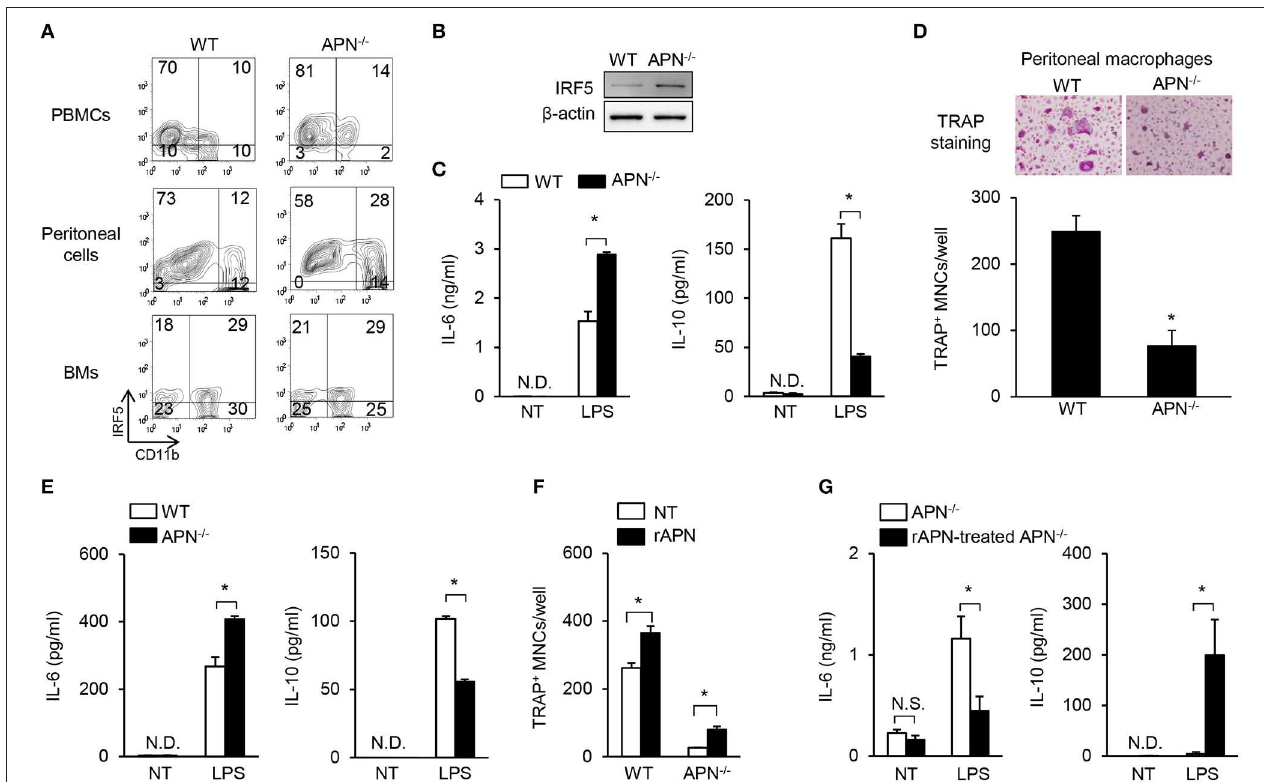
FIGURE 5 | Macrophages derived from adiponectin-deficient mice have M1-like properties and attenuated osteoclastogenic potential. (A) PBMCs, peritoneal cells, and bone marrow cells (BMs) were blocked with anti-CD16/CD32 antibody and then stained with FITC-conjugated anti-CD11b antibody. The stained cells were fixed, permeabilized, and stained with mouse anti-IRF5 antibody followed by incubation with Cy3-conjugated anti-mouse IgG. The stained cells were analyzed using flow cytometry. Numbers indicate the percentage of each panel. One of two similar results is shown. (B) BMMs were differentiated from stroma free-bone marrow cells by incubation with M-CSF (20ng/ml) for 5 days. Cell lysates were prepared and subjected to immunoblots to detect IRF5. (C) BMMs were stimulated with LPS (0.1 µ g/ml) for 24h. The culture supernatants were analyzed to determine the production of IL-6 and IL-10 using ELISA. (D) Peritoneal macrophages were isolated and incubated with M-CSF (20ng/ml) plus RANKL (40ng/ml) for 4 days. The cells were fixed and stained for TRAP. TRAP + MNCs were photographed (magnification, × 200) and enumerated. (E) Peritoneal macrophages were stimulated with LPS (0.1 µ g/ml) for 24h. The culture supernatants were analyzed to determine the productions of IL-6 and IL-10 using ELISA. (F,G) Bone marrow cells were incubated with rAPN (2 µ g/ml). After 24h, stroma free-bone marrow cells were harvested and washed to remove the remaining rAPN. (F) The cells were incubated with M-CSF (20ng/ml) and RANKL (40ng/ml) for 3 days and stained for TRAP. The numbers of TRAP + MNCs were counted. (G) The cells were incubated with M-CSF (20ng/ml) for 5 days and then stimulated with LPS (0.1 µ g/ml) for 24h. The culture supernatants were analyzed to determine the production of IL-6 and IL-10. NT, non-treatment; N.D., not detected; rAPN, recombinant adiponectin; Data are mean values ± SD of triplicate samples and are representative of three similar independent experiments. * P <